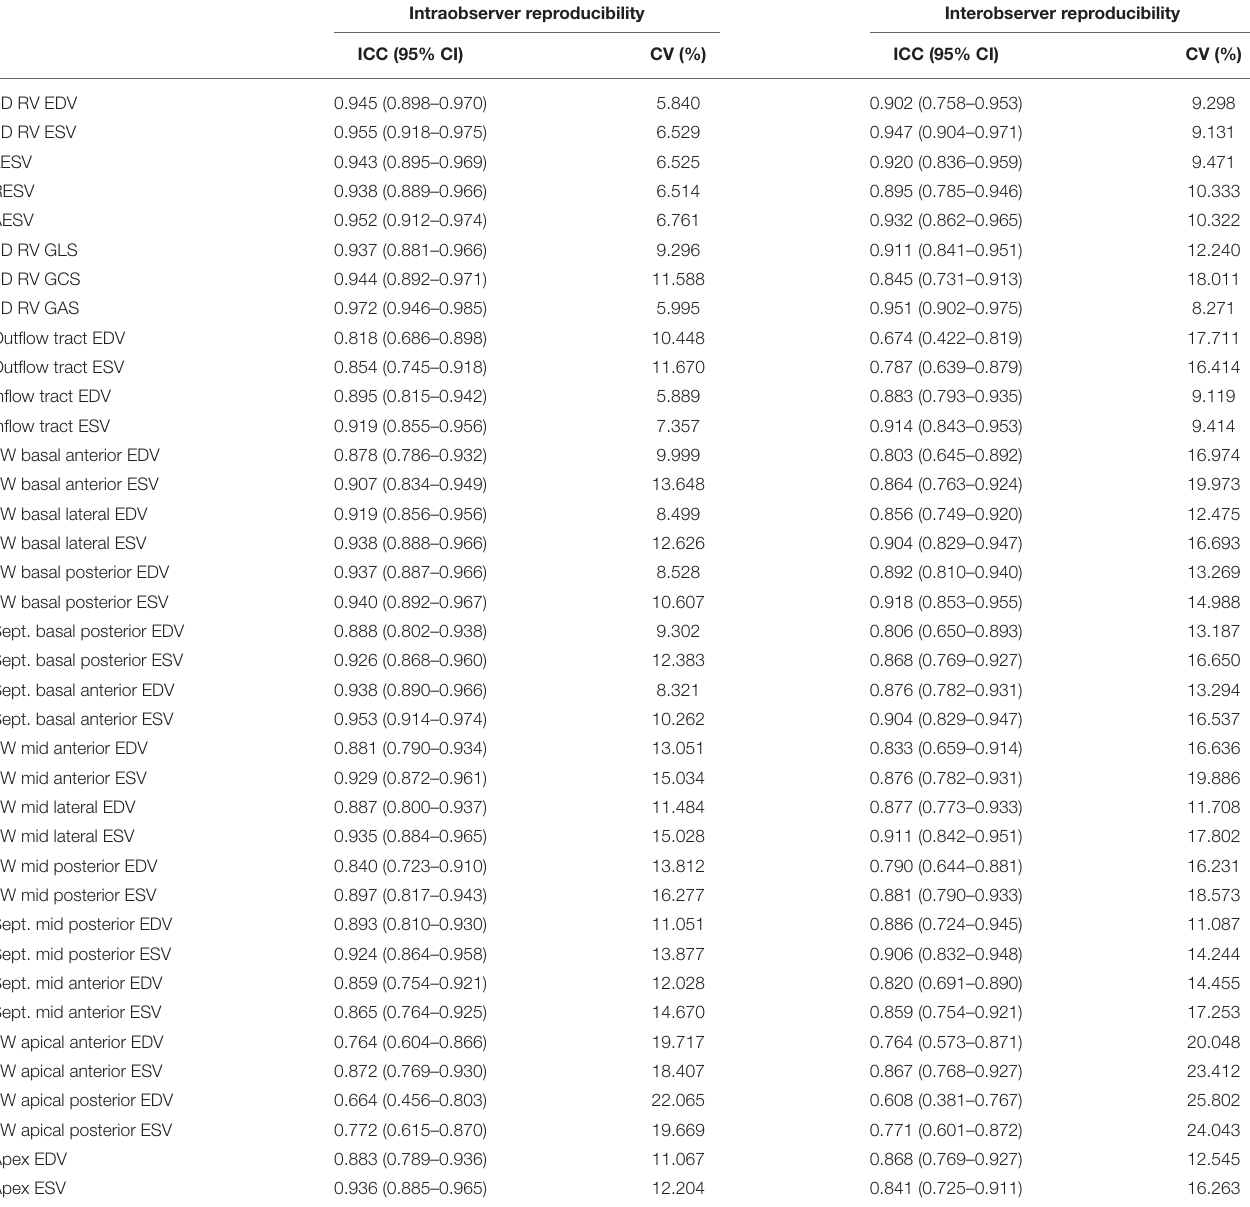
TABLE 2 | Intra- and interobserver variability and reliability of global and segmental right ventricular